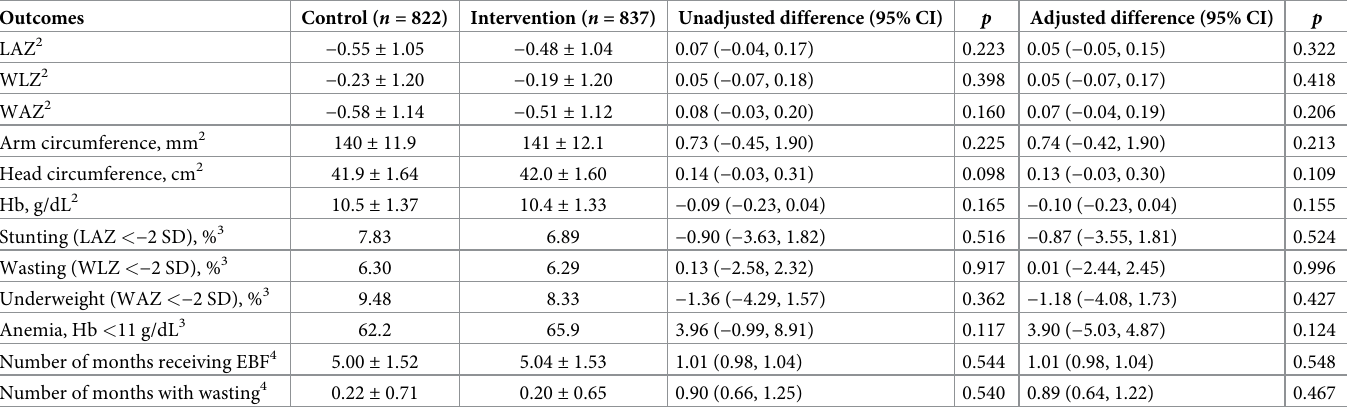
Table 2. Effect of maternal postnatal BEP supplementation on infant growth and nutritional status at 6 months 1